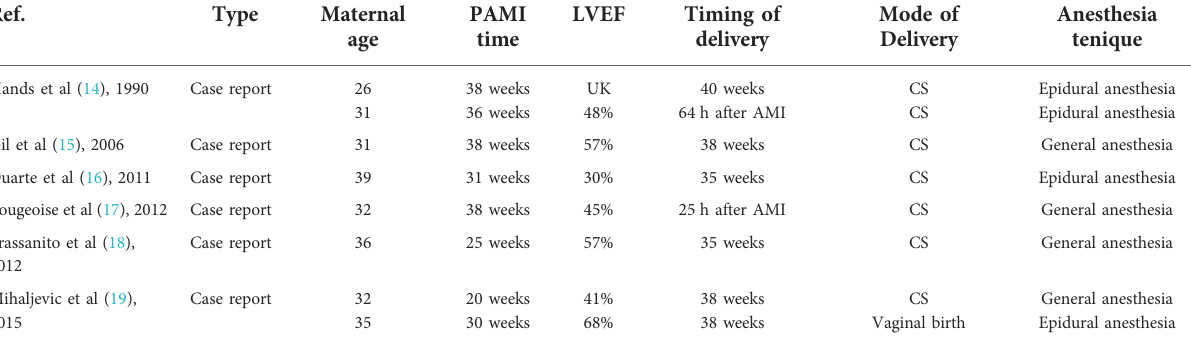
TABLE 1 Summary of case reports of anesthesia management for acute myocardial infarction (AMI) in pregnancy.